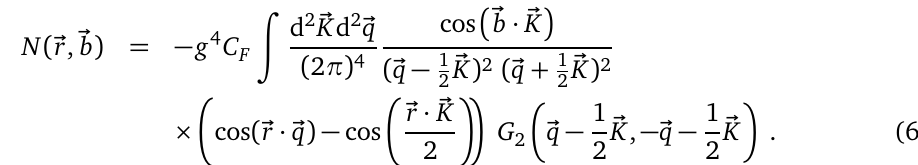
Figure 2: Left: Color charge correlator G for various relative gluon transverse momenta (cid:126) q ation with the collinear cutoff, over the range m = 0.1...0.4 GeV. Right: cross section for exclusive J / Ψ photoproduction versus squared